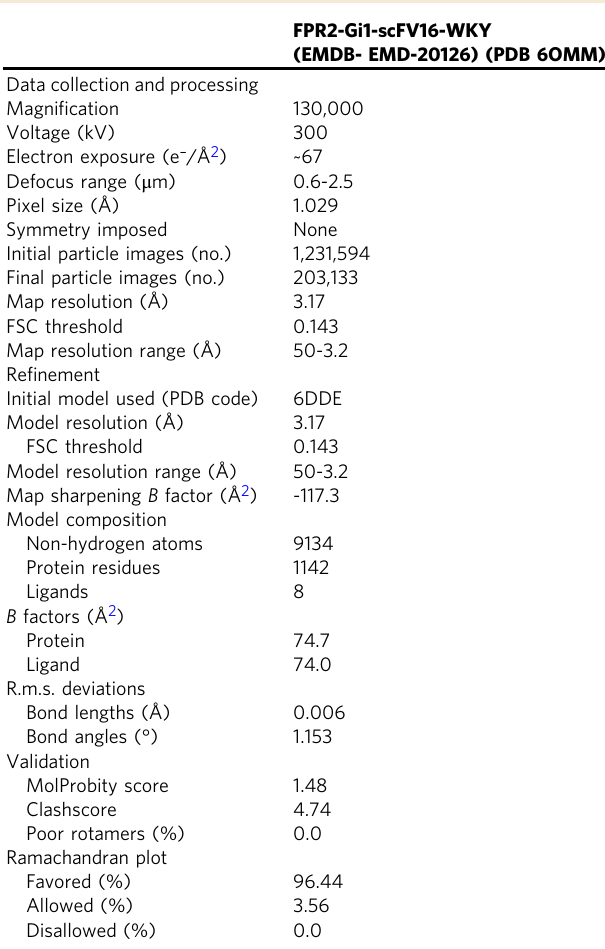
Table 1 Cryo-EM data collection, model re fi nement and validation